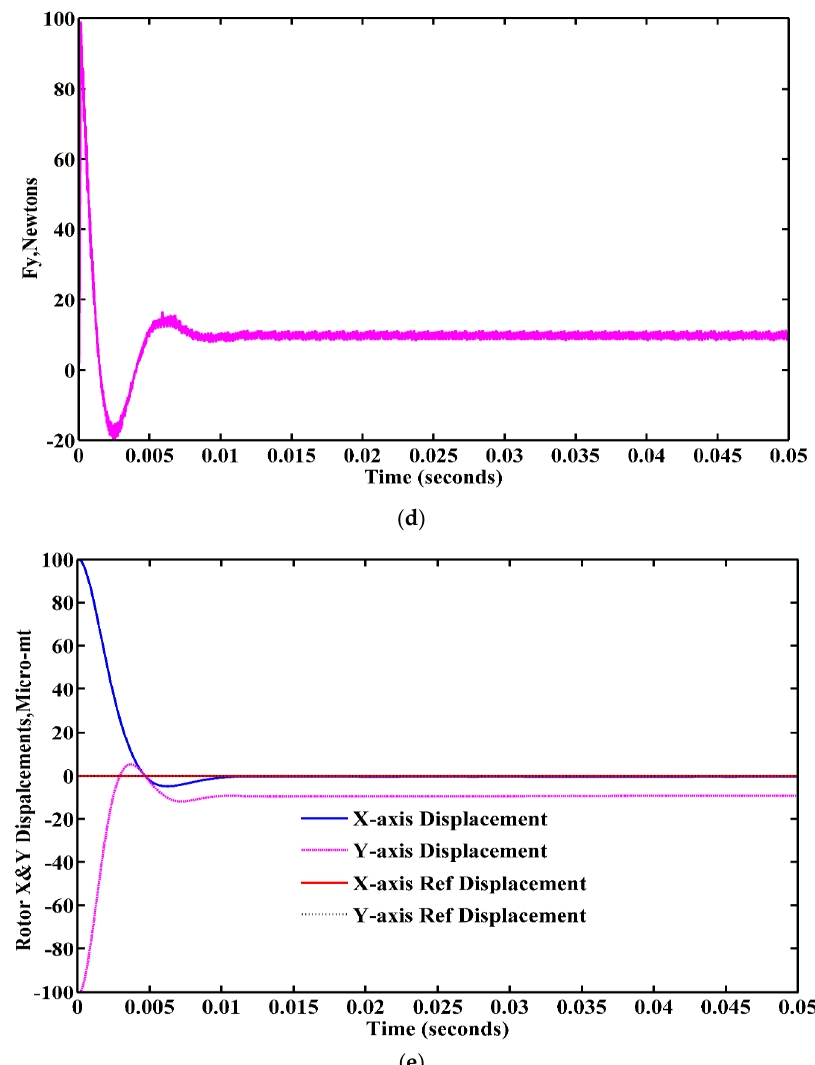
Figure 11. BSRM Suspension parameters. ( a ) Four-phase controlled suspension winding voltages; ( b ) Four-phase controlled suspension phase currents; ( c ) Resultant suspension force Fx; ( d ) Resultant suspension force (F y ); ( e ) Rotor X and Y displacements.